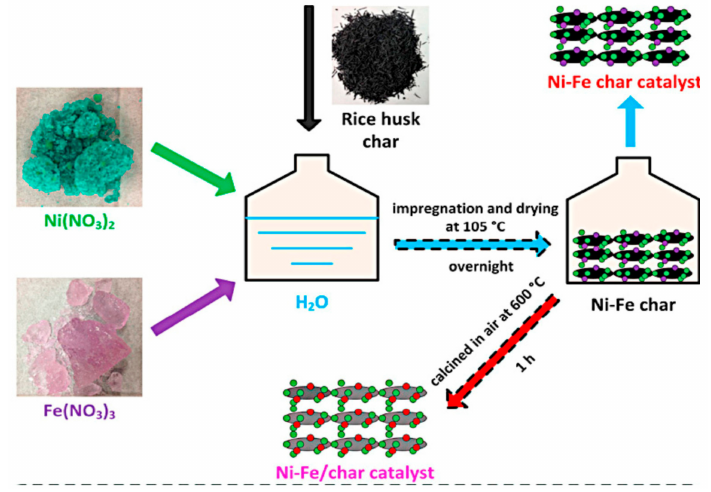
Figure 12. Schematic of a two-step method for the synthesis of an Ni/Fe–char catalyst, reprinted with permission from Reference [153]. Copyright (2014) Elsevier